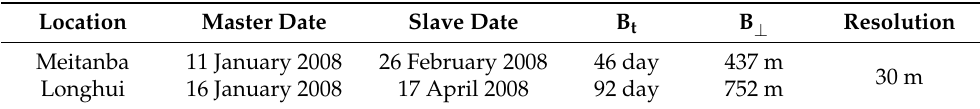
Table 2. ALOS-1/PALSAR-1 images used in the